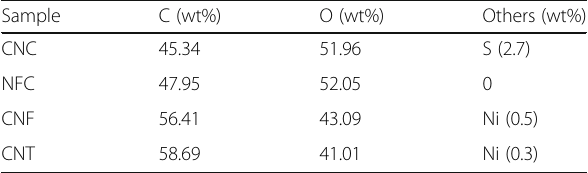
Table 1 EDX results for different nanomaterials Sample